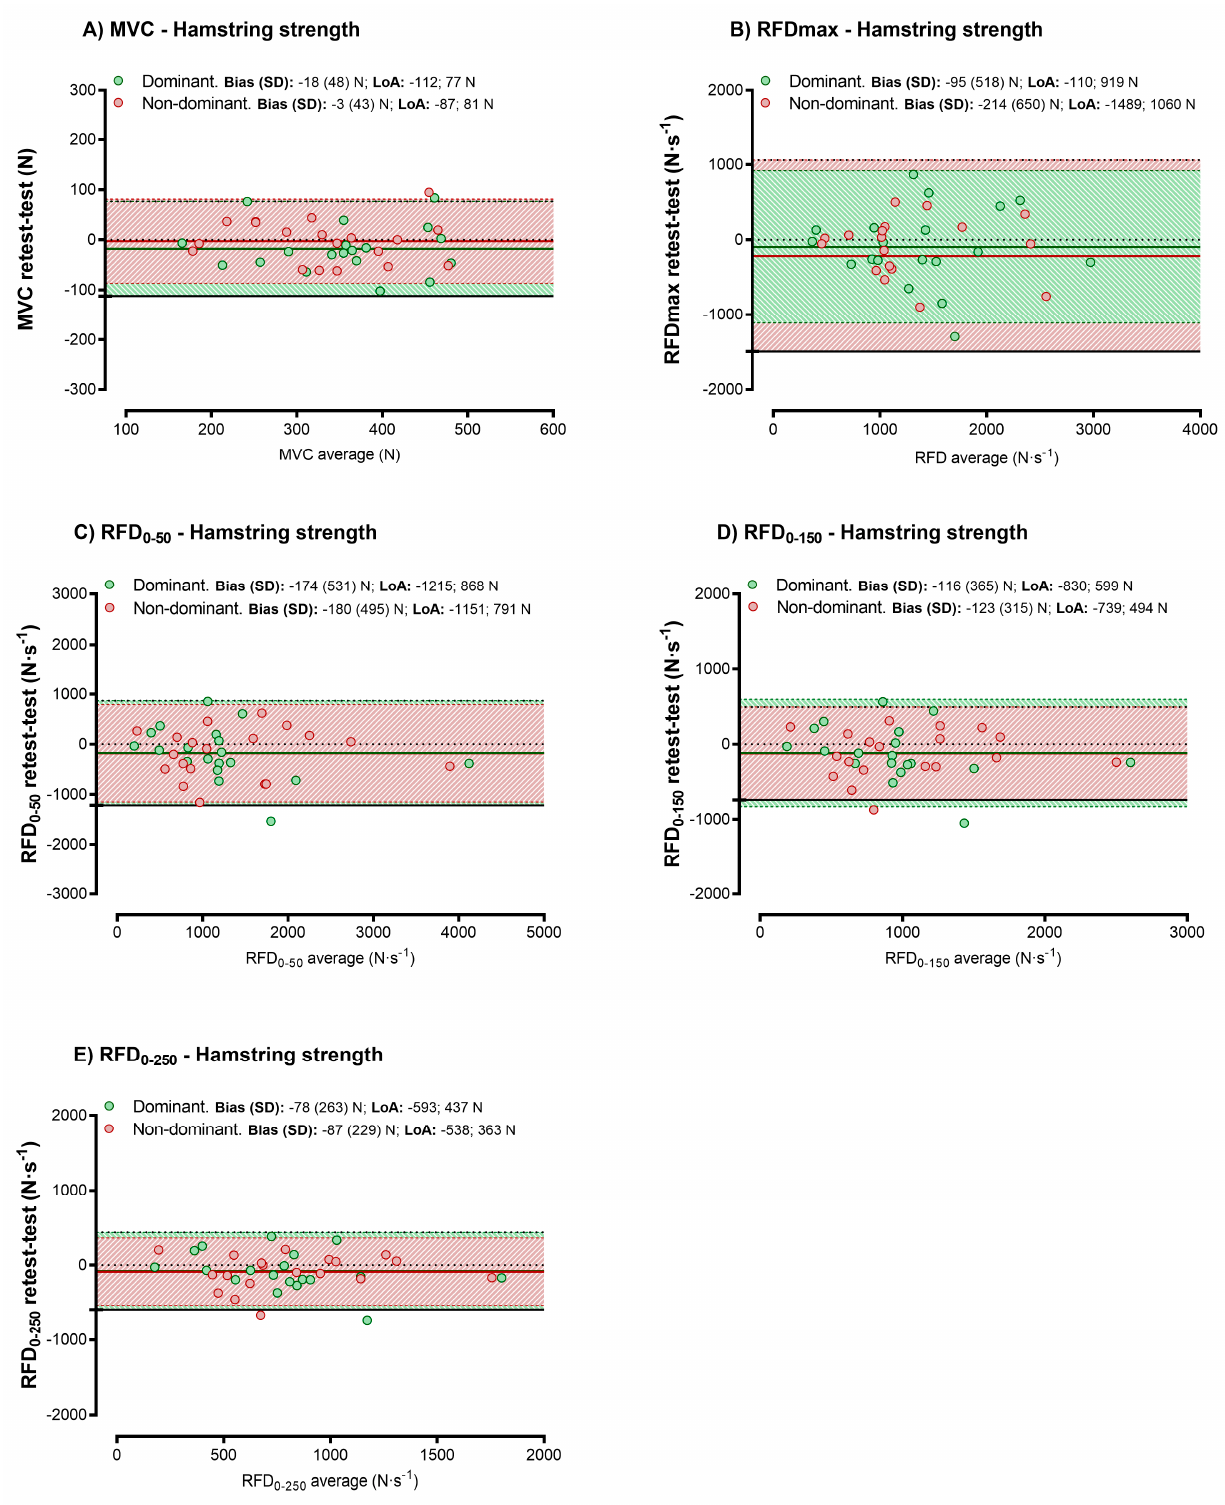
Figure 2. ( A – E ) Bland–Altman plots show the bias (test-retest differences) for the isometric hamstring strength test. Shadows are limits of agreement (LoA) for dominant (green, clear) and non-dominant (red, dark) legs.